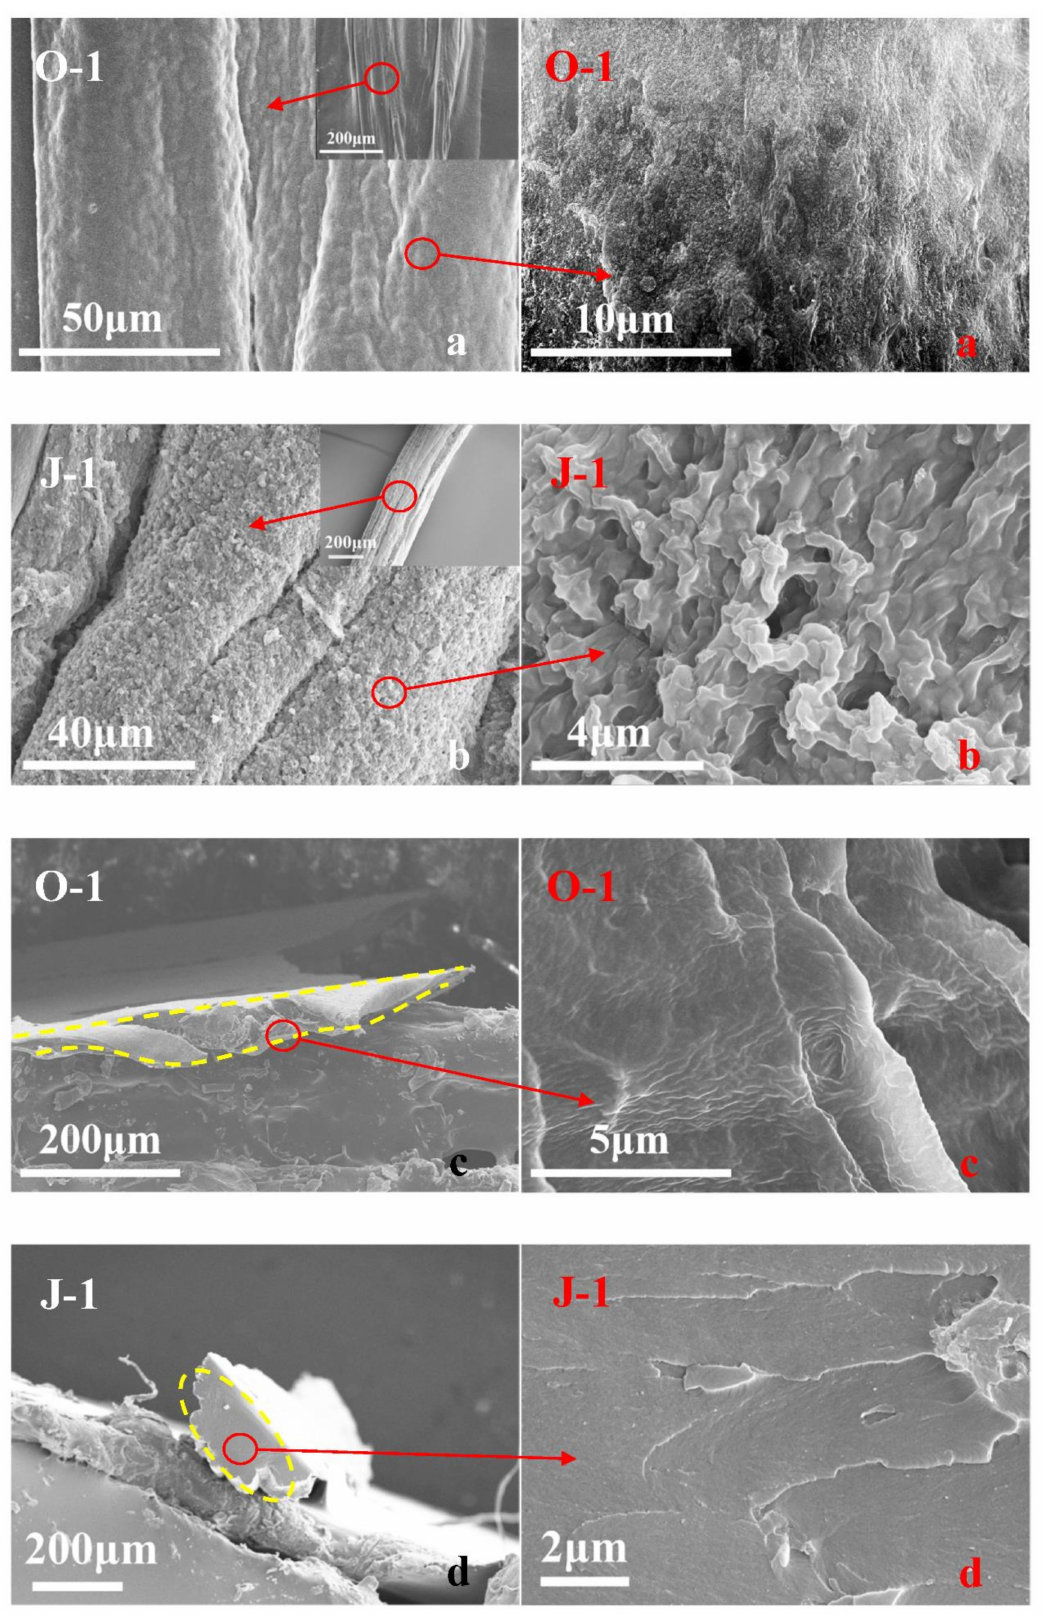
Figure 3. SEM images of the fibers obtained before and after crosslinking treatment; fiber O-1 is defined in Section 2.3, and fiber J-1 is described in Section 2.4; the surface of fiber O-1 ( a ), the surface of fiber J-1 ( b ), the cross section of fiber O-1 ( c ) and the cross section of fiber J-1 ( d